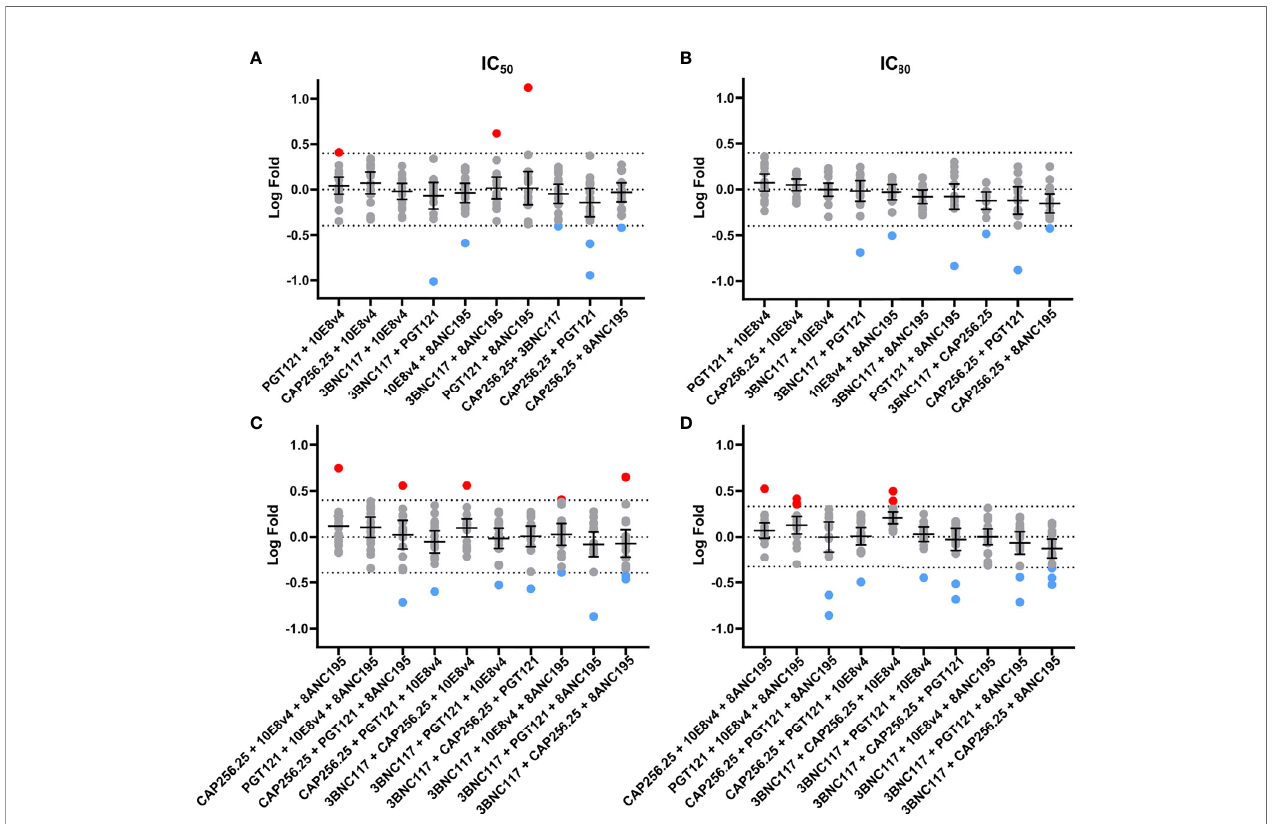
FIGURE 4 | No synergy observed using fold difference between experimental and Bliss-Hill predictions of dual and triple scFv combinations. Log-fold differences of double and triple IC 50 (A, C) and IC 80 (B, D) experimental combinations to the Bliss-Hill Independence model prediction. Mean and the 95% con fi dence interval are shown with a dotted line indicating no fold change. Log (2.5) fold difference dotted lines (0.4 or -0.4) are also shown. Red and blue are used to indicate more than a log difference of 0.4 (~2.5x) with red dots indicating potential synergy and blue dots indicating potential